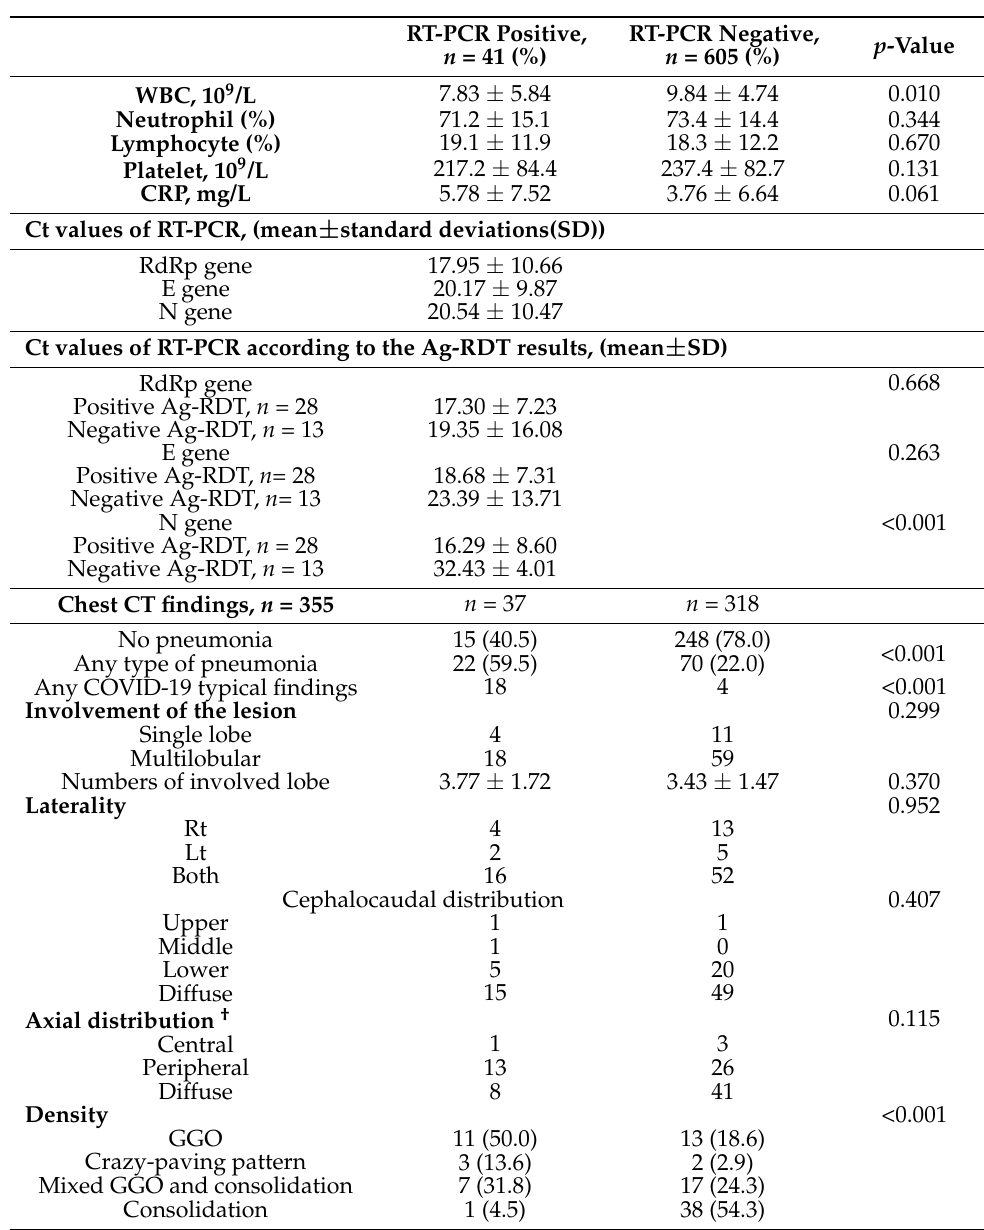
Table 3. Laboratory and radiologic findings in admitted